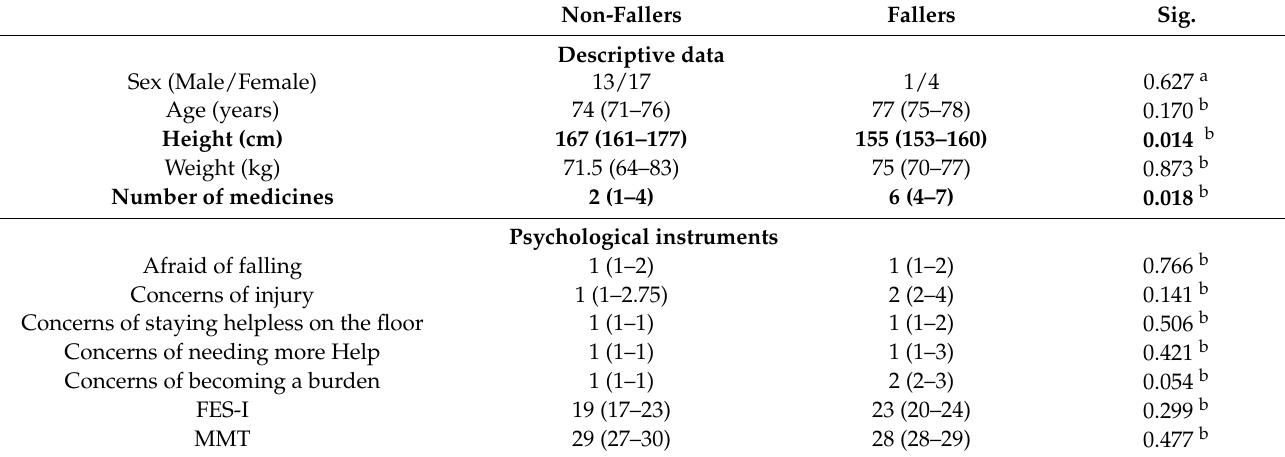
Table 1. Descriptive data of both groups are presented in median and interquartile